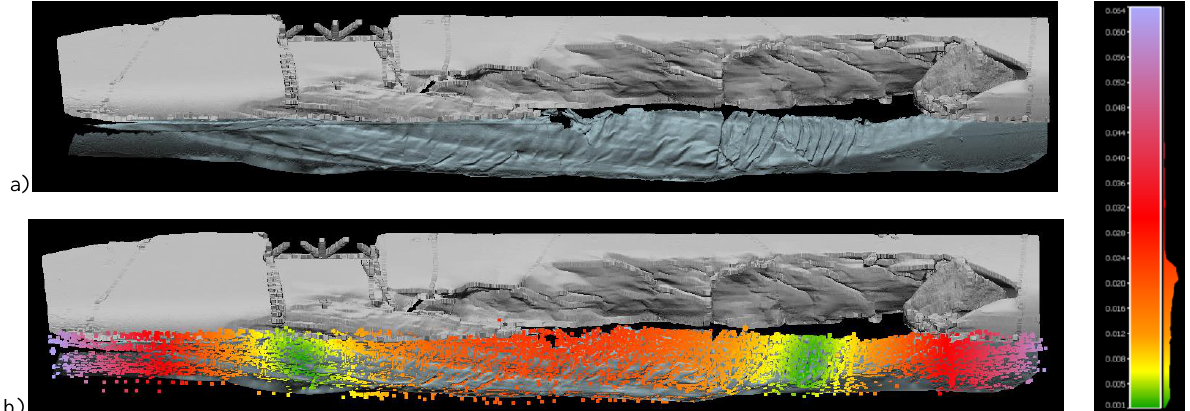
Figure 12. (a) Mesh model of the Costa Concordia gash. (b) Colour maps of Euclidean distances [m] between tie points of the underwater part with and without decentring distortion